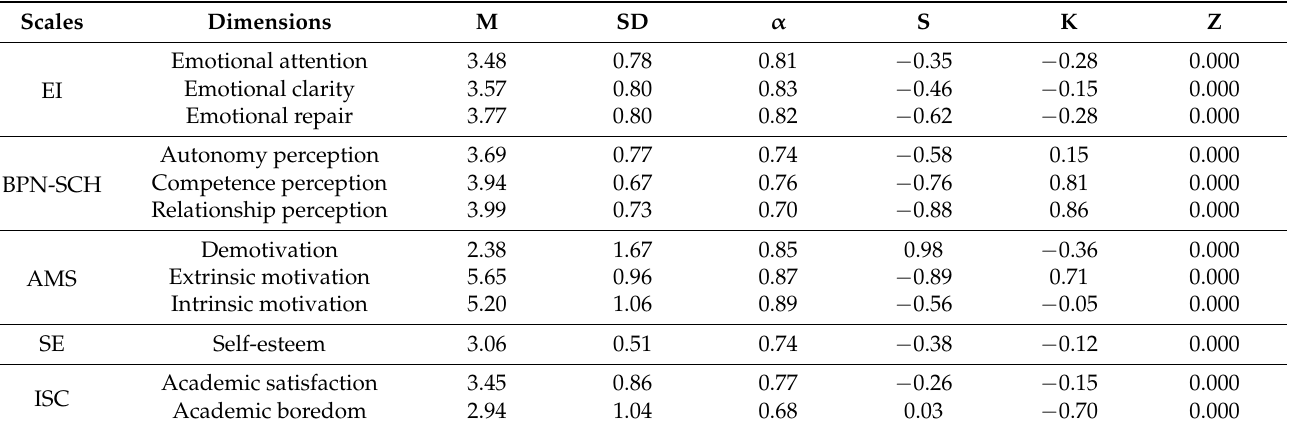
Table 2. Descriptive analysis, internal consistency, and normality of the EI, BPN-SCH, AMS, SE, and ISC scales.